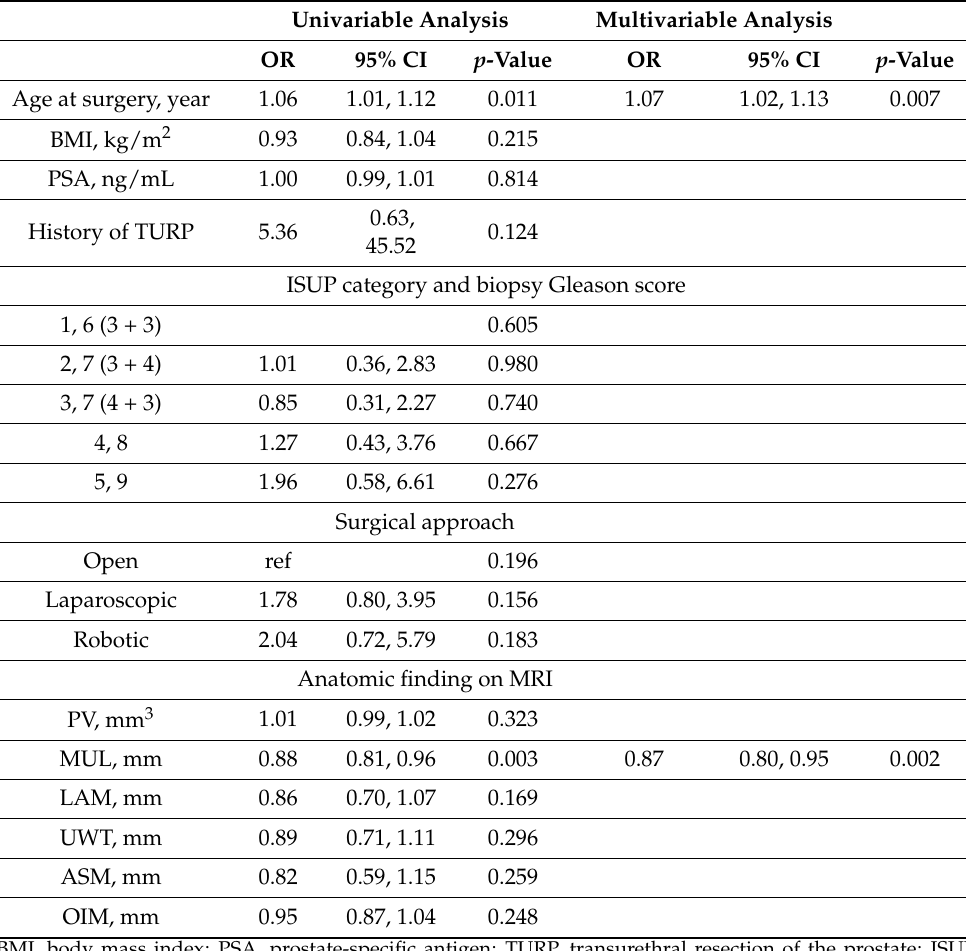
Table 4. Univariable and multivariable analysis for recovery from PPI within 3 months.